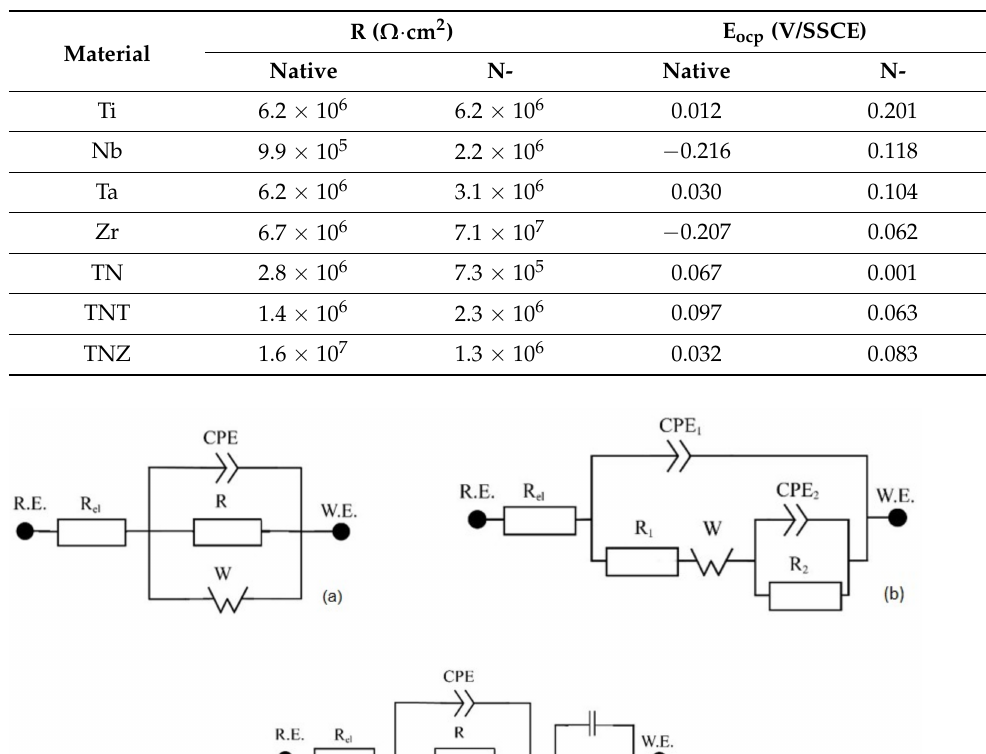
Table 3. Corrosion parameters determined from electrochemical measurements in physiological solution.